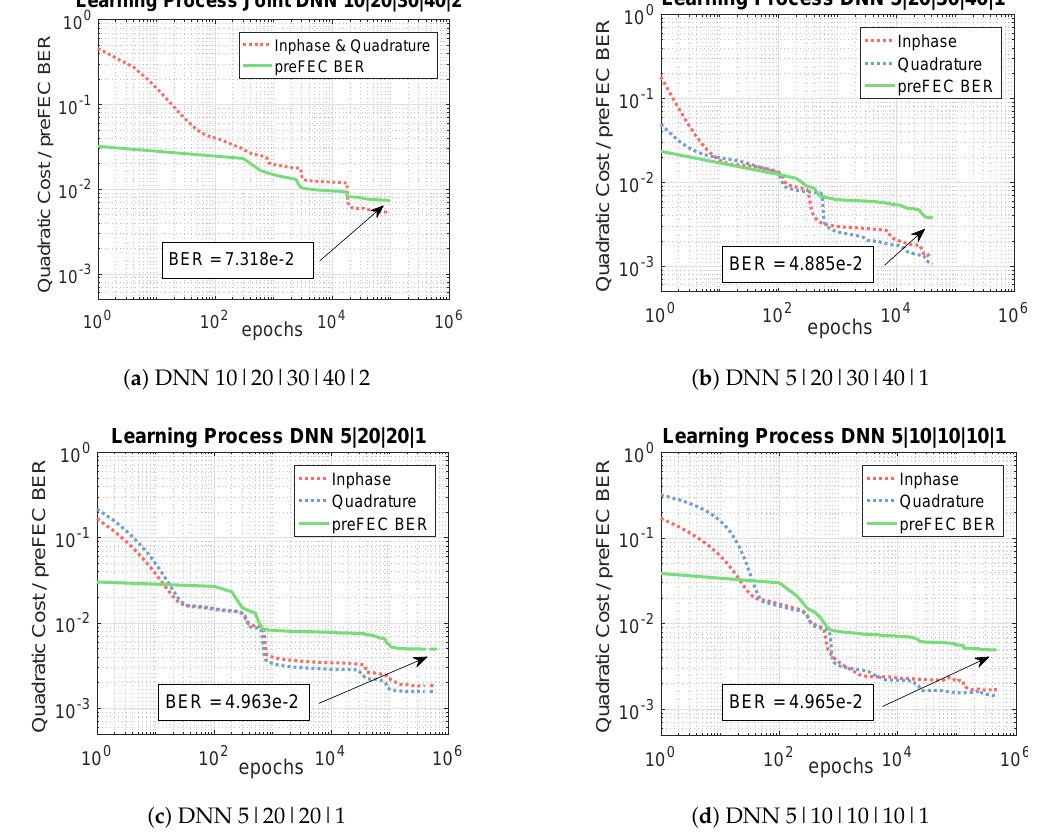
Figure 10. Learning Process of three different DNN